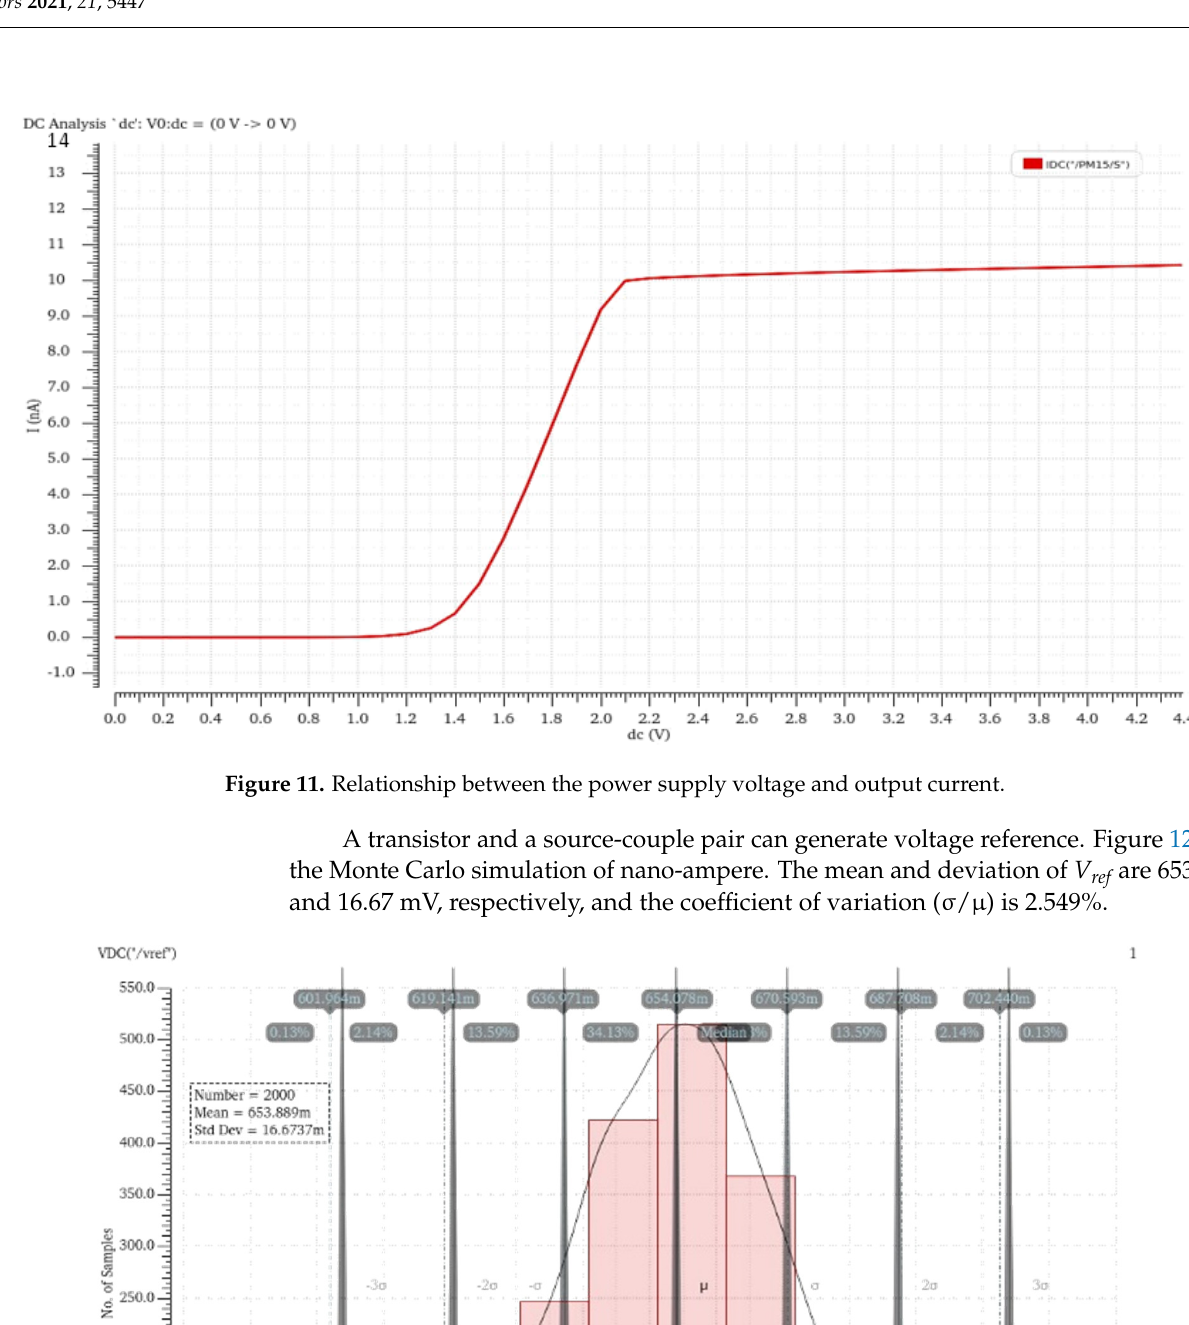
Figure 13. The circuit of the current-hungry voltage control oscillator.